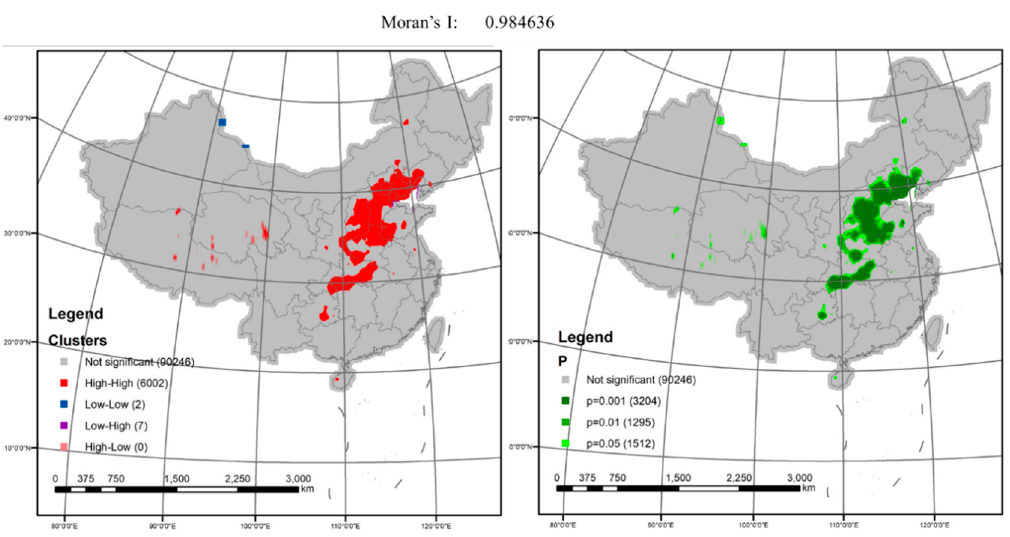
Figure 5. Moran’s I scatter plot ( left ) and p -values ( right ) in China from 19 to 20 July 2016.